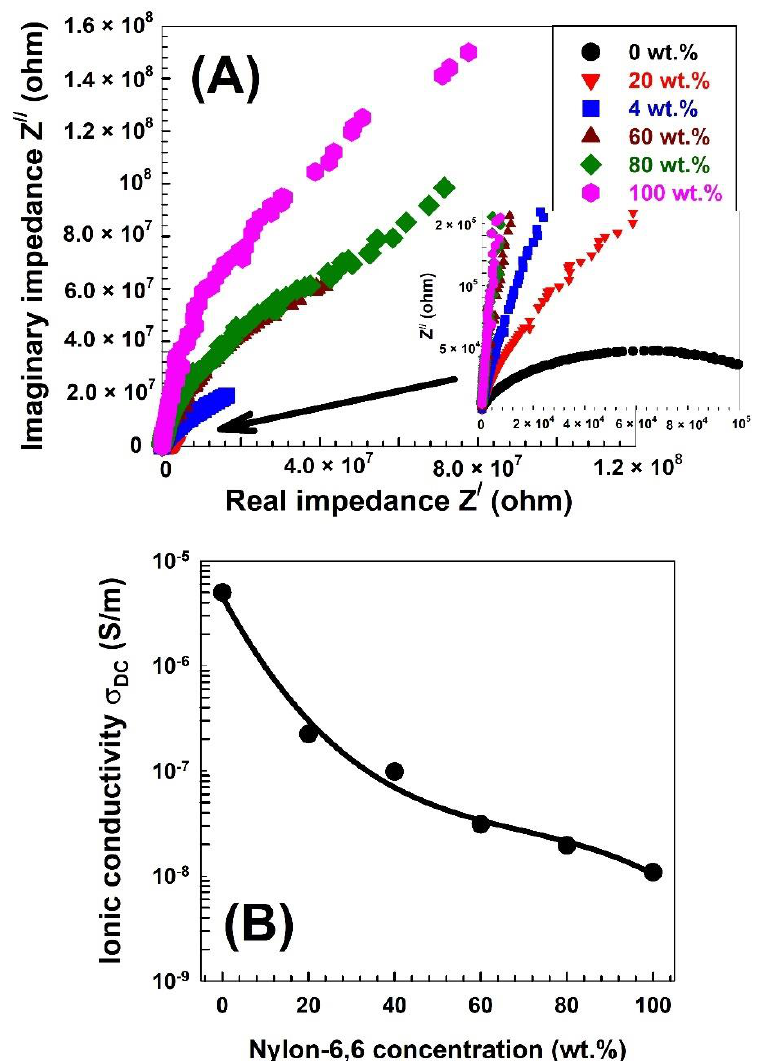
Figure 7. ( A ) Cole – Cole plot for the PVA blended with different concentrations of Nylon-6,6 and ( B ) the DC ionic conductivity σ DC as a function of the Nylon-6,6 concentrations blended with PVA.